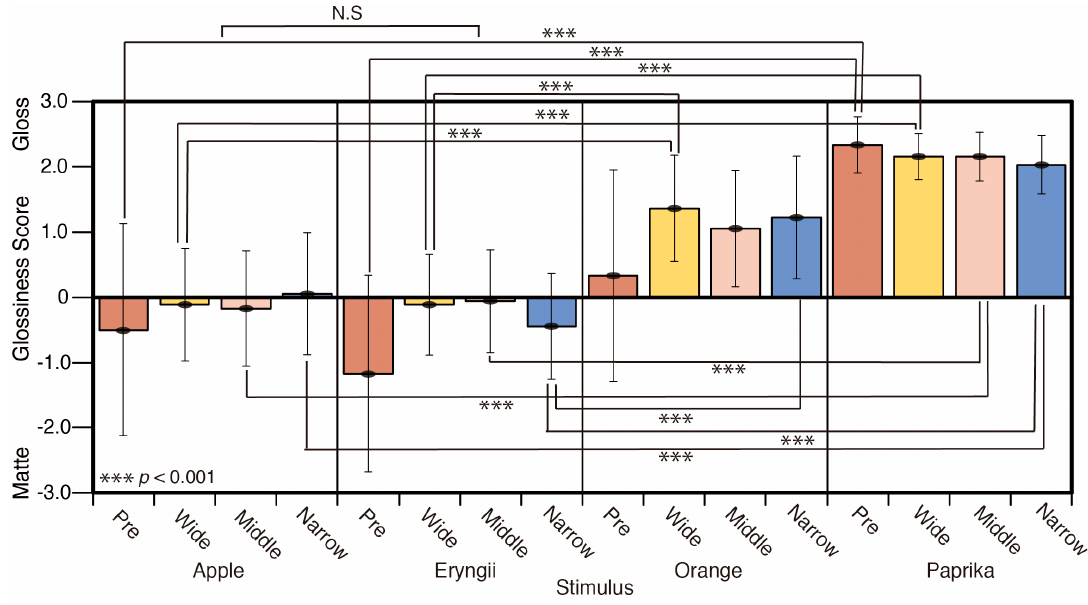
Figure 11. Glossiness scores.